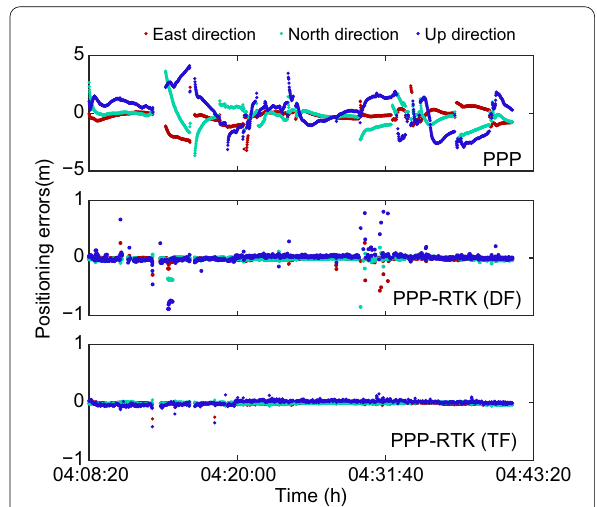
Fig. 5 Positioning series of PPP and dual-/tiple-frequency PPP-RTK in the urban environment. DF and TF indicate dual-frequency and triple-frequency, respectively